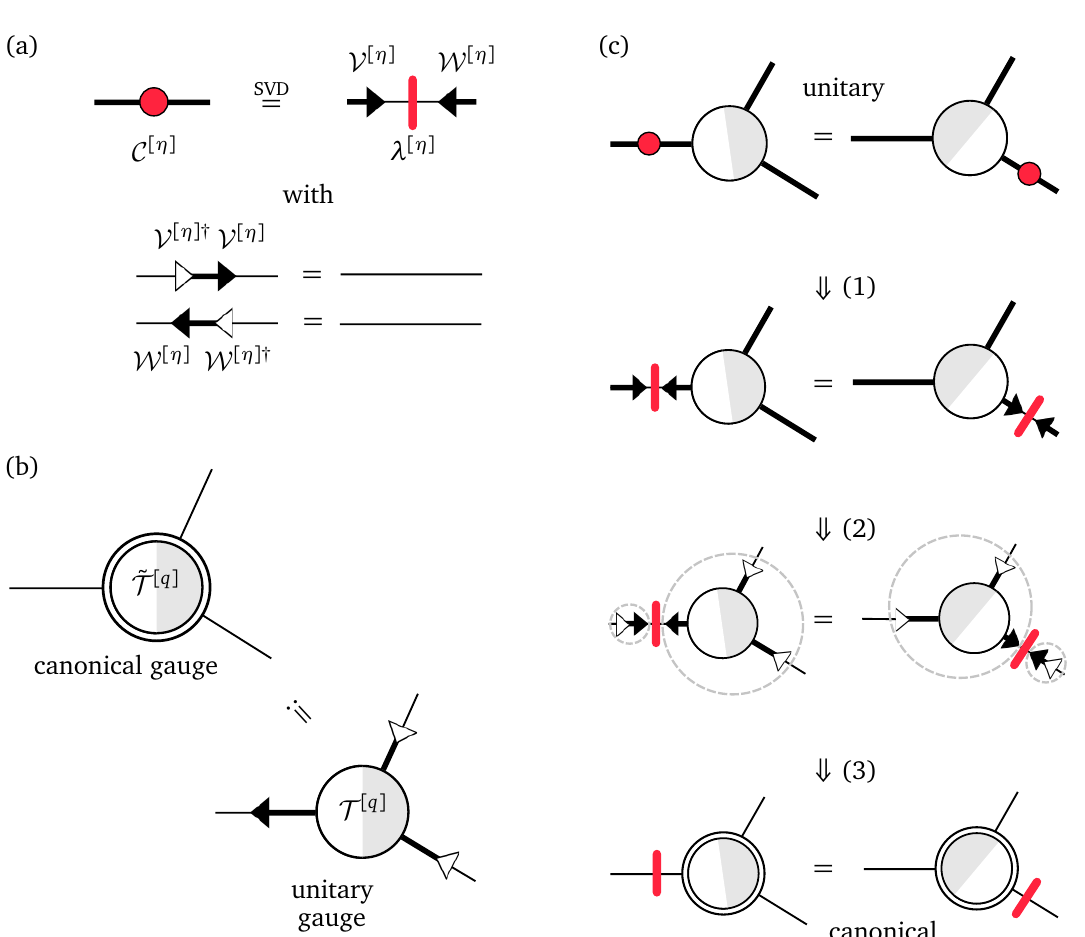
Figure 29: Transformation from unitary- to canonical gauge: (a) We define isometries W [ η ] , V [ η ] (black triangles, pointing towards the center singular values) and their one-sided inverses (white) from left- and right singular vectors of the unitary-gauge center matrices C [ η ] (red) on all virtual links η in a TN. (b) The canonical-gauge tensor (double outline) is obtained from the unitary-gauge tensor by absorbing, from all virtual links, those isometries that point towards the current TN gauge center C [ η ] sitting on some network link η . Inverses are taken if tensor links lead away from the center. When repeated on each tensor, this procedure establishes the canonical gauge by insertion of link-local gauges VV † or W † W on each non-center virtual link (cf. Fig. 30), and V [ η ] λ [ η ] W [ η ] on the center link η . (c) The isometry relation of the canonical gauge (bottom) follows from the isometry relation in the unitary gauge (top): We (1) perform SVDs on the center matrices and (2) multiply all (virtual) links on both sides with the respective inverse isometries pointing towards the tensor node. (3) By exploiting (a) and (b), we recover an identity and the definition of a canonical tensor. The result (bottom) is the isometry relation in the canonical gauge picture. In order to visualize the compression to minimal bond dimension, entailed by the SVD, we assign different line widths to links of different